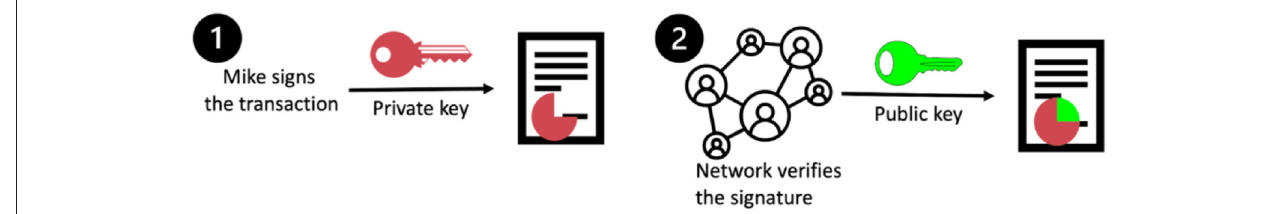
FIGURE 1 | Verification of Mike’s identity.